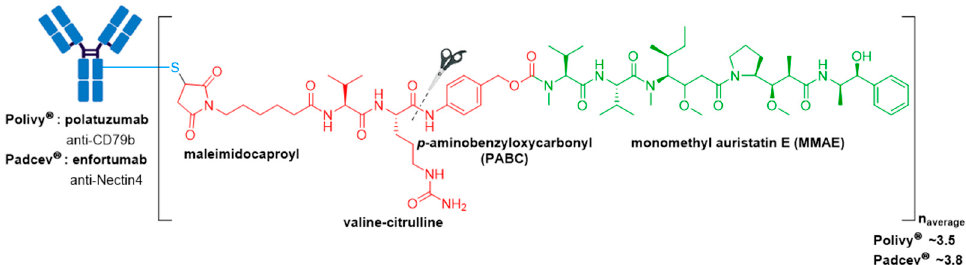
Figure 10. Structure of Polivy ® (polatuzumab vedotin-piiq) and Padcev ® (enfortumab vedotin-ejfv). The antibody is shown in blue, and chemical structures for linker and payload are in red and green, respectively.